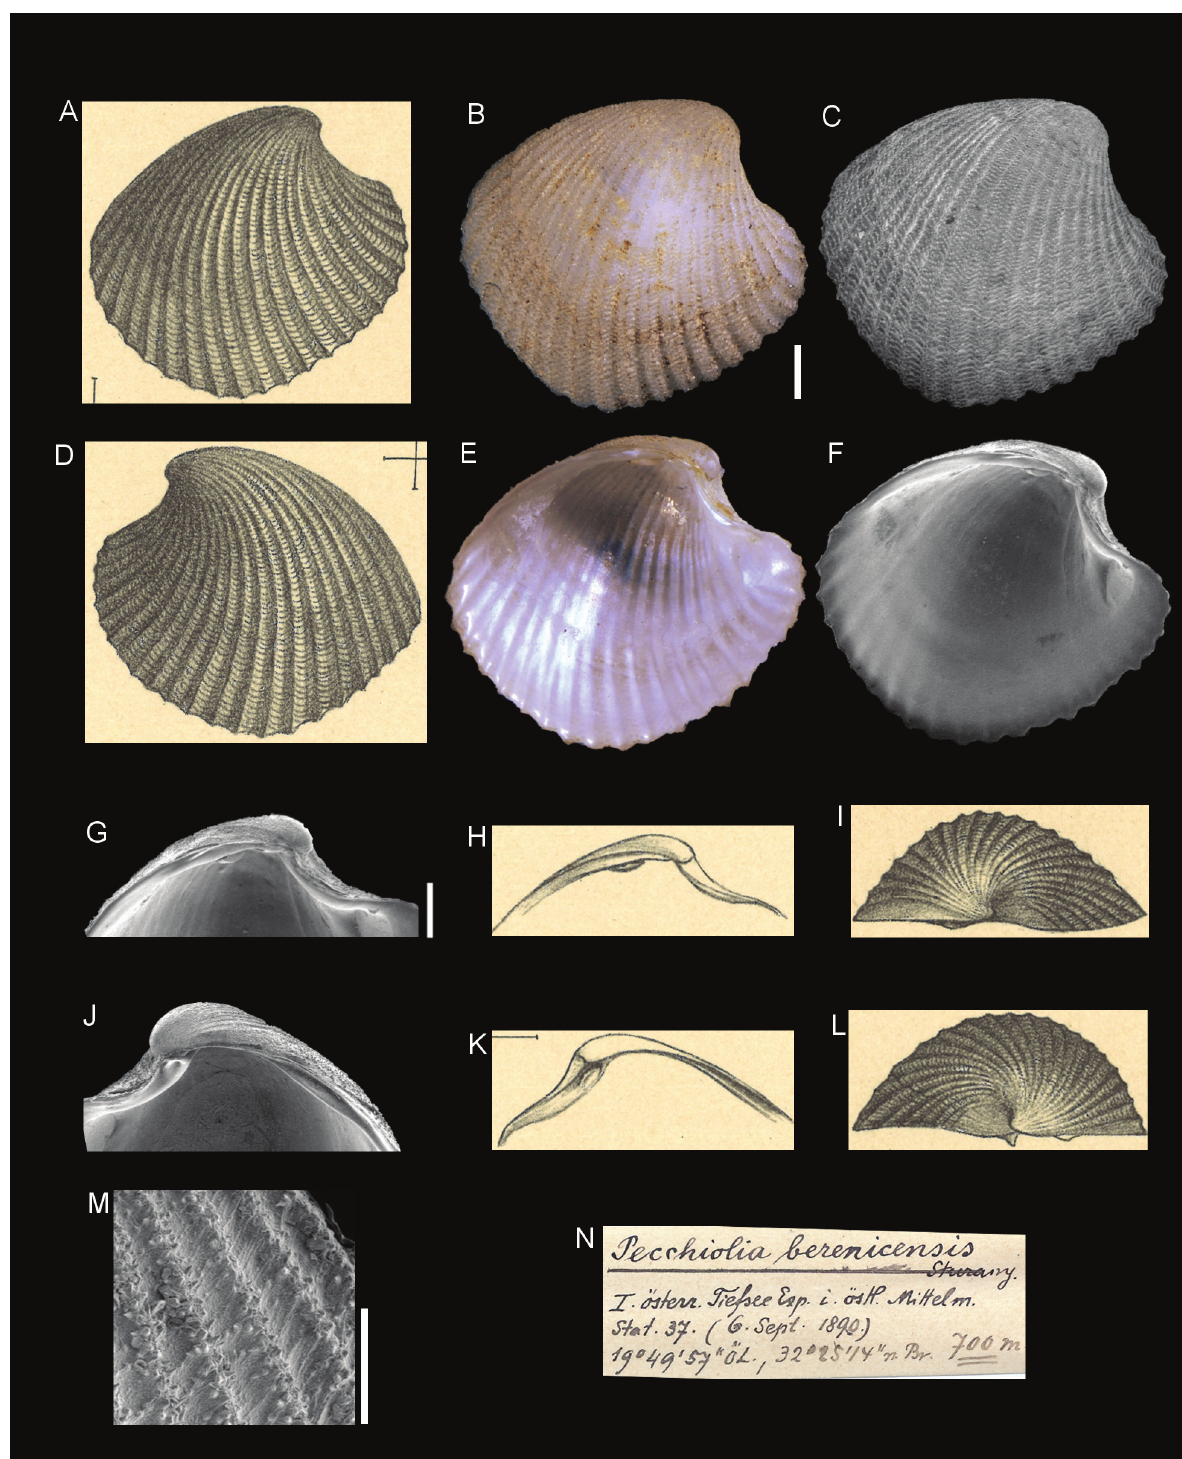
Figure 15. Pecchiolia berenicensis Sturany, 1896, Station 37, north of Benghazi, Libya, 700 m. A , D , H–I , K–L . Original figures in Sturany, 1896. B–C , E–G , J , M . Holotype NHMW 13007: outer view left valve ( B–C ), inner view right valve ( E–F ), hinge detail of right ( G ) and left valve ( J ), sculpture detail ( M ). N . Original label. Scale bar: 1 mm ( B–C, E–F, G, J ), 0.5 mm ( M